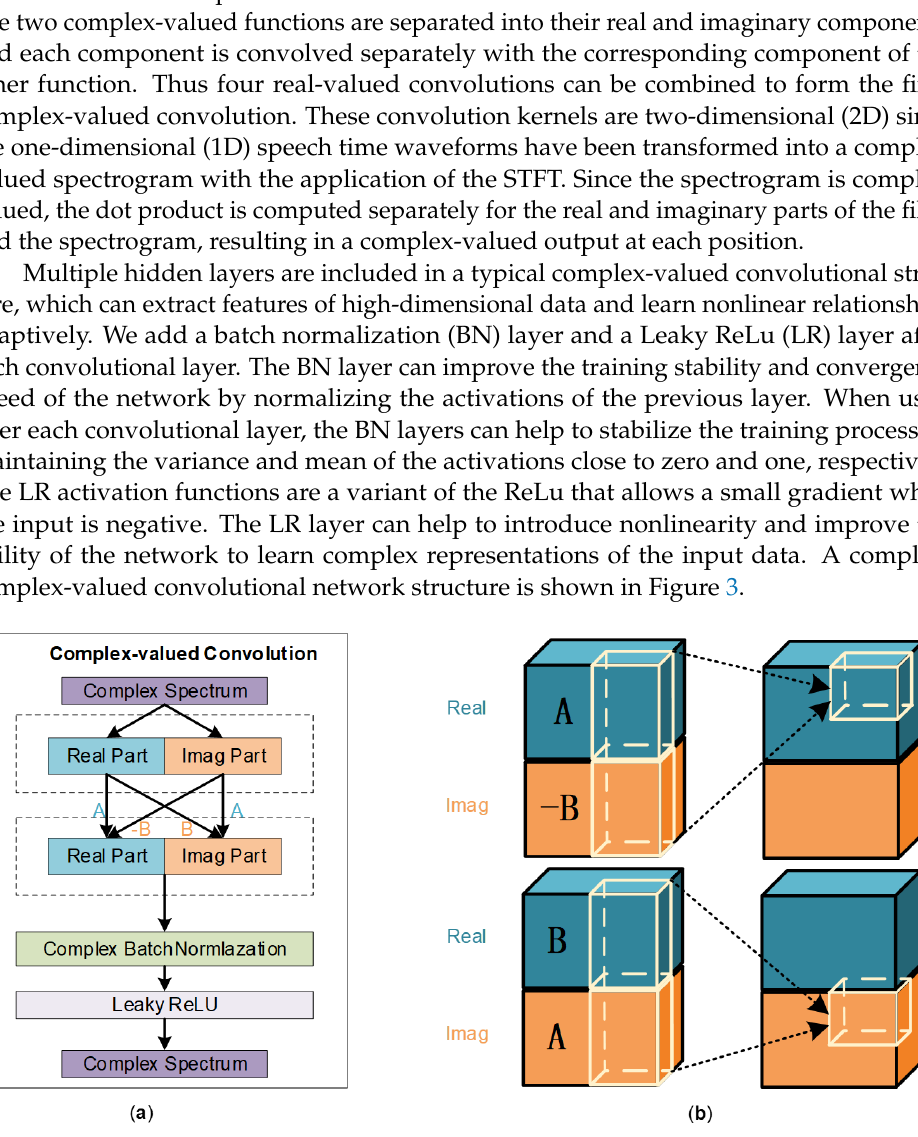
Figure 3. ( a ) The specific structure of complex-valued convolution. ( b ) Calculation of real and imaginary parts in complex-valued convolution operations.